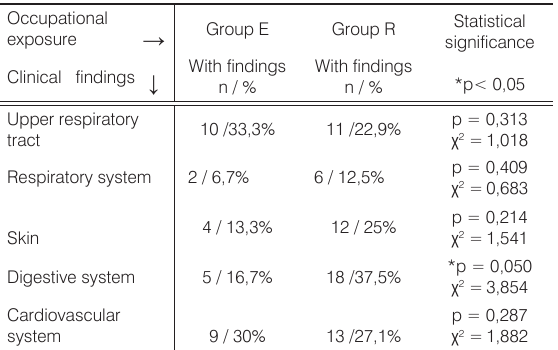
Table 3. Distribution of clinical findings in the group of subjects occupationally exposed to formaldehyde and the referents (* p <0,05). ↓→